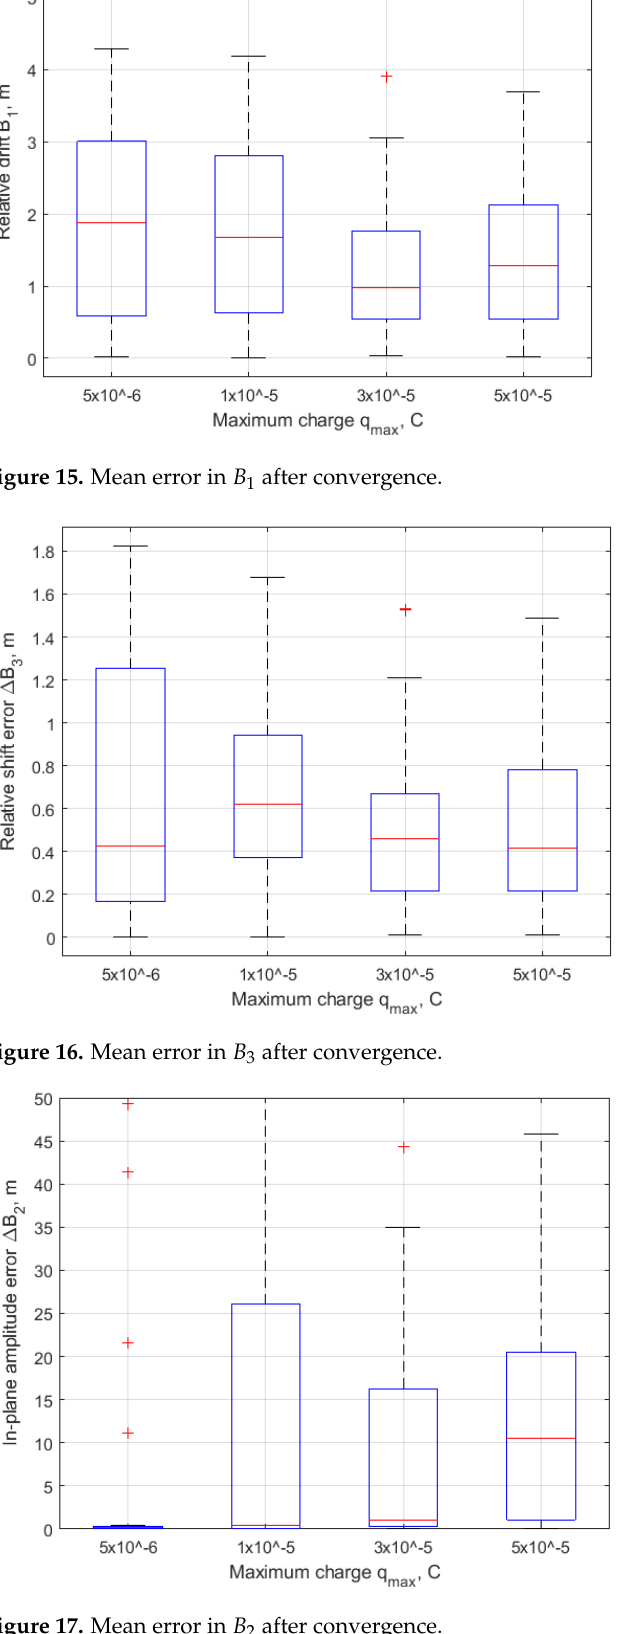
Figure 18. Mean error in 4 B after convergence. Since the control is based on the Lorenz force which is the result of the cross product of the local magnetic field and the velocity, the controllability of this system depends on variation of magnetic field, i.e., its direction must change over time in the LVLH frame. However, if the satellite is in equatorial orbit, the geomagnetic field vector is almost con- stant during the orbital motion. These constraints on the geomagnetic field vector direc- tion could influence the control algorithm performance. The Monte Carlo simulations were performed for the fixed parameters presented in Table 1 and different values of the orbit inclination. For the equatorial orbit, the proposed Lorenz force control is not working as follows from the simulation results. It is caused by the almost fixed geomagnetic field vector along the orbit and as a result the only direction of the Lorenz force. The control algorithm started to achieve the required trajectory beginning from approximately 30 deg of inclina- tion.